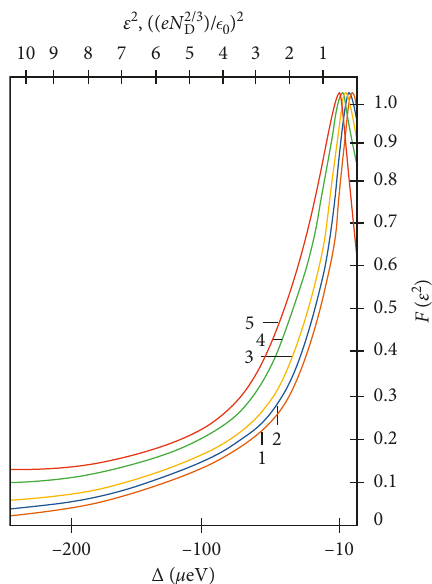
2p line, determined by the qua- + 1 3 0, N D a B (cid:29) 4 × 10 (cid:29) ⟶ ∗